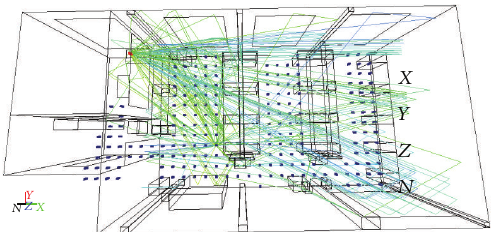
Figure 3: Ray-launching in an indoor environment.